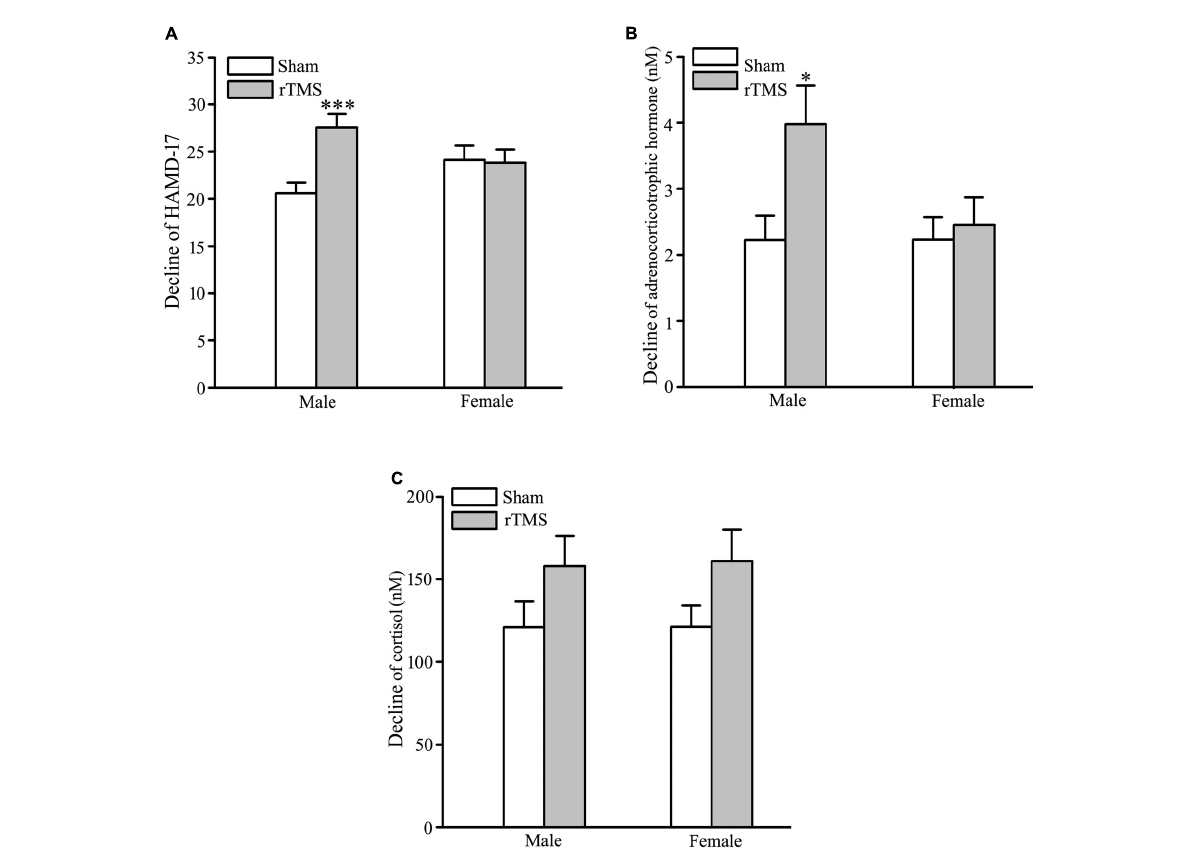
FIGURE4 Gender-specificity of repetitive transcranial magnetic stimulation (rTMS) on depressive symptom and hypothalamic–pituitary–adrenal (HPA) axis. (A) Change in the total score of 17 items Hamilton depression rating scale (HAMD-17) from baseline to post-intervention at 4 weeks in male and female patients. (B,C) Change in the concentration of adrenocorticotropic hormone (ACTH) (B) and cortisol (COR) (C) from baseline to post-intervention at 4 weeks in male and female patients. rTMS group significantly different from the sham group was marked by asterisks. ∗ p < 0.05, ∗∗∗ p < 0.001, compared with the sham group. Graphs show mean ± SEM; n =